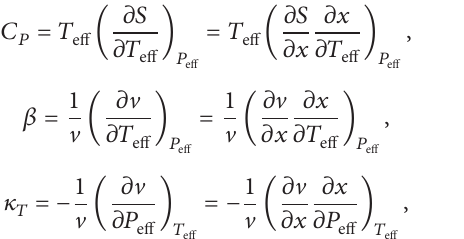
> 𝑇 𝑐 the effective temperature 𝑇 , the stable condition eff eff < 0 can be satisfied. In the case of 𝑇 < 𝑇 𝑐 (𝜕𝑃/𝜕𝑉) , there 𝑇 eff eff eff > 0 ; thus, in exists a portion in the curve, where (𝜕𝑃/𝜕𝑉) 𝑇 eff these parts, the system is unstable. So, phase transition may = 𝑇 𝑐 occur only at 𝑇 eff eff